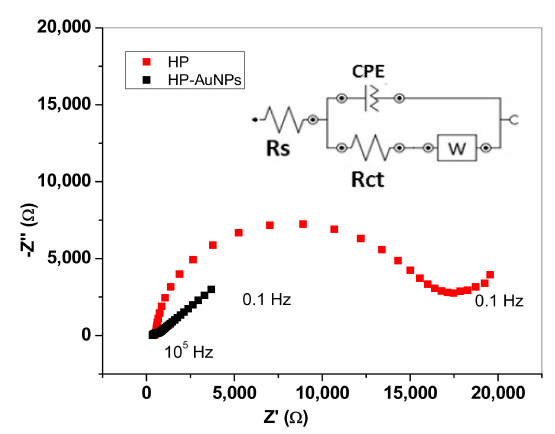
Figure 5. Nyquist plot obtained for HP (red) and HP-AuNPs (black) electrodes in solution containing 1.0 mM K 4 [Fe(CN) 6 ] + 0.2 M KCl; applied potential: + 0.265 V for HP and + 0.220 V for HP-AuNPs.